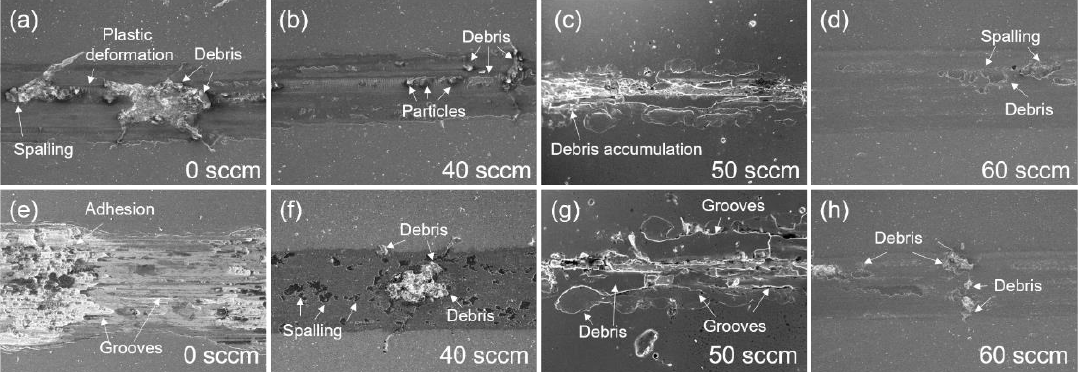
Figure 14. The SEM morphologies of the worn track of the TiAlN coatings deposited at different nitrogen flux rates. Wear track with a wear time of 3 min ( a – d ), wear track with a wear time of 30 min ( e – h